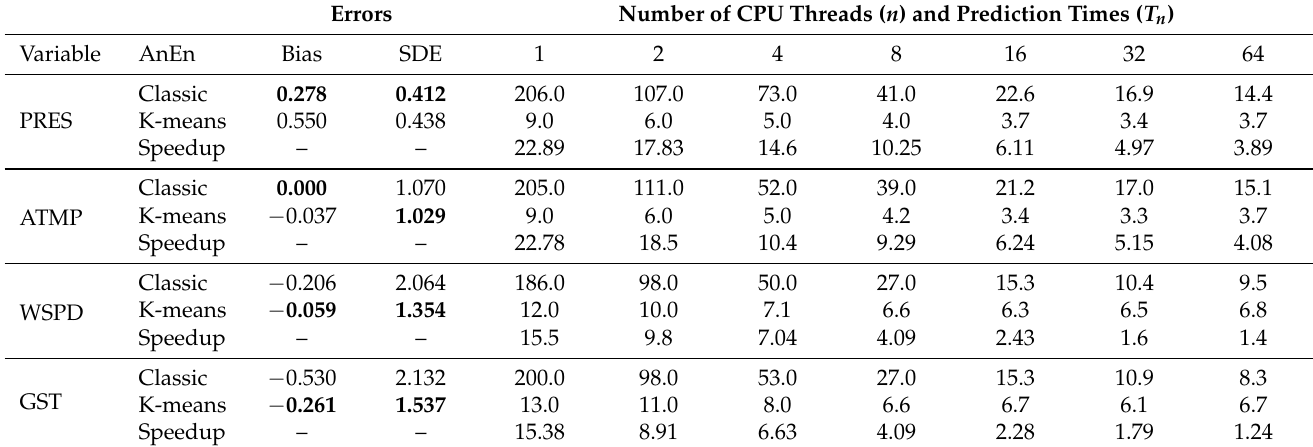
Table 7. Classical vs. K-means AnEn: prediction errors, computation times [s] and K-means Speedup.